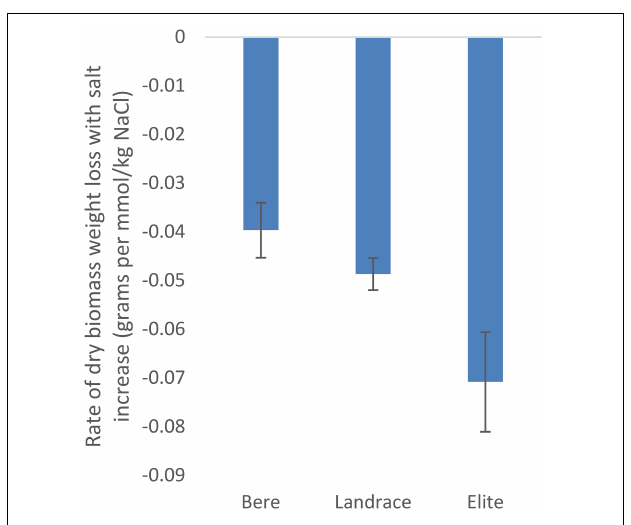
FIGURE 1 | The salinity tolerance as measured by the average change in dry weight with increasing salt concentration for 146 lines/cultivars of barley divided into three groups, Bere, Other landraces, and elites ( n = 37, n = 104, and n = 5, respectively). Complete resistance is represented as 0, with negative measurements showing susceptibility. Error bars represent the standard errors in positive and negative